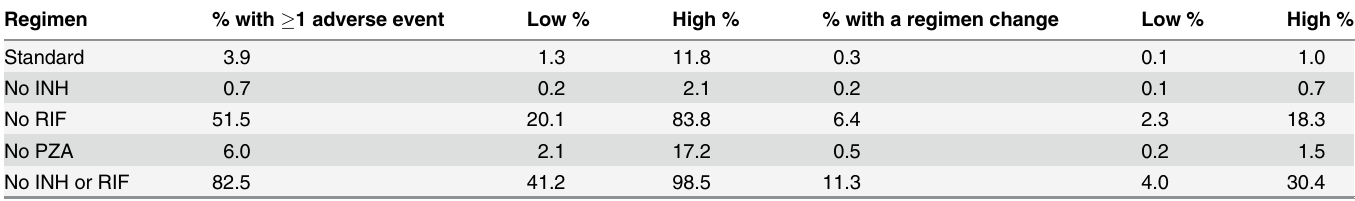
Table 5. Proportion of patients projected to experience at least one adverse event, and proportion of patients projected to experience a regimen change, by initial regimen a,b Regimen % with (cid:1) 1 adverse event